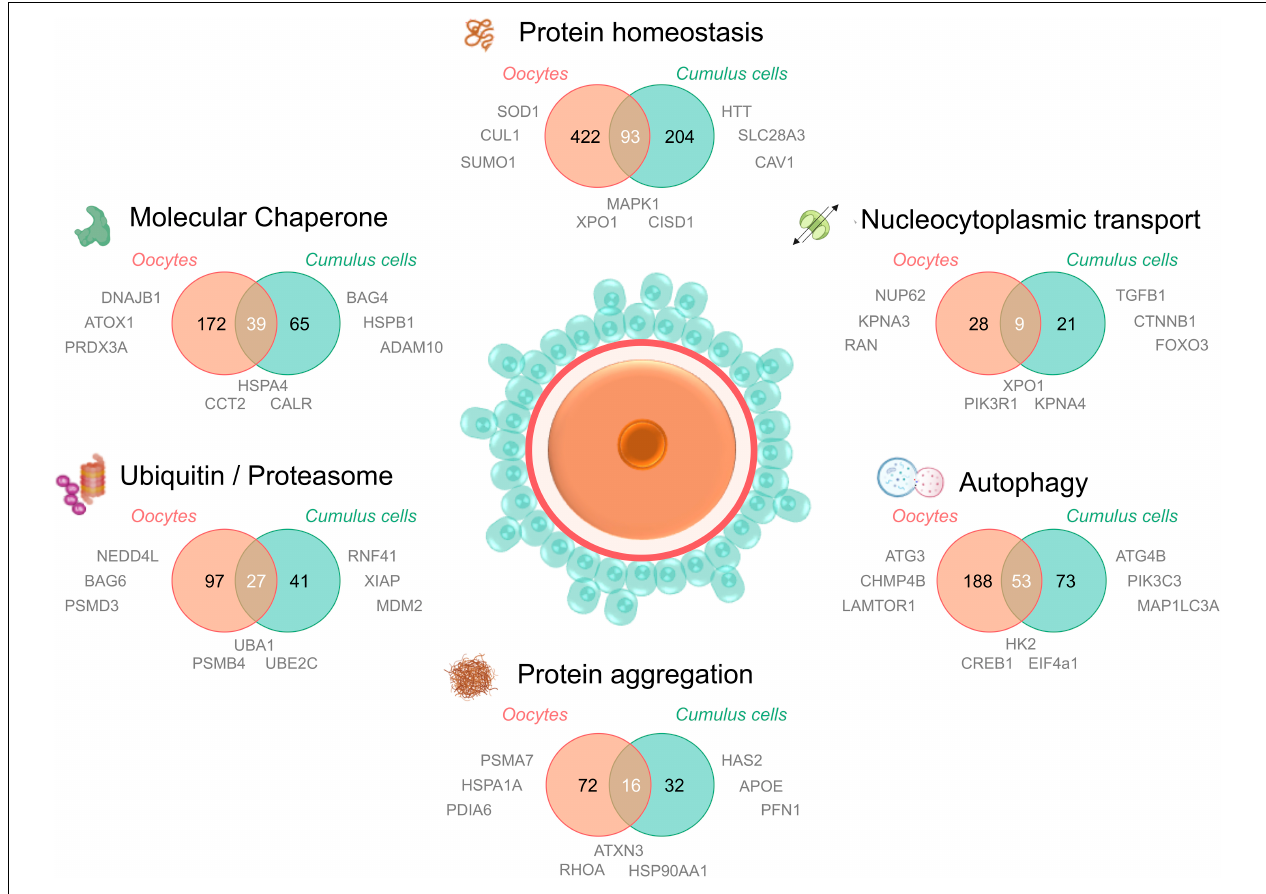
FIGURE 3 | Proteomic/transcriptomic evidence for the dysregulation of the protein homeostasis network in aged oocytes and cumulus cells. To understand the contribution of proteostasis to aging in oocytes and cumulus cells, four recent proteomic and/or transcriptomic datasets of maternally aged oocytes and cumulus cells (Oocytes; Schwarzer et al., 2014; Duncan et al., 2017; Cumulus cells; McReynolds et al., 2012; Al-Edani et al., 2014) were analyzed for dysregulated elements involved in proteostasis. Proteins and transcripts were defined as “age-dysregulated” by individual cut offs (fold change and significance) specified by the authors of each primary research paper. A database of all proteostasis network related proteins was compiled from neXtProt (Zahn-Zabal et al., 2020; v2.27.0; https://www.nextprot.org; neXtProt Data release 17/01/2020) through six individual searches titled “Protein homeostasis, Protein aggregation, Autophagy, Nucleocytoplasmic transport, Ubiquitin/proteasome, and Molecular chaperone.” Human neXtProt protein accessions were then mapped to their UniProt mouse homologs to generate both mouse and human proteostasis databases (found in Supplementary File 1 ). Age-dysregulated proteins and transcripts listed in the Supplementary Material of the four primary manuscripts were uniformly converted to their corresponding mouse homologs and UniProt protein accessions and used to search for corresponding proteostasis related ID’s in the 6 NeXtProt database categories. These data were used to generate Venn diagrams comparing the putative age-dysregulated proteins in oocytes vs. cumulus cells and to supply relevant examples of dysregulated proteins adjacent to the component of interest. Aged oocyte IDs were from CBCF1 mice aged between 14 and 17 months (climacteric) and aged cumulus cell IDs were from cumulus-oocyte complexes from women of equivalent advanced maternal age (37–45 years). Examples included in Figure 3 were selected from age-dysregulated protein IDs. Full protein names, UniProt accessions, the proteostasis network database used to generate this figure, and lists of oocyte and cumulus cell dysregulated protein accessions can be found in Supplementary File 1 . The sharing of IDs between aged oocytes and cumulus cells is putative but provides novel candidates for research into the contribution of declining proteostasis to reproductive aging. Elements of this figure were made in